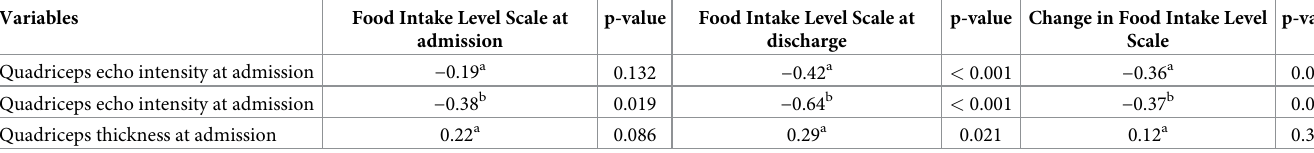
Table 2. Associations of echo intensity and muscle thickness of the quadriceps with Food Intake Level Scale at admission and discharge and with change in Food Intake Level